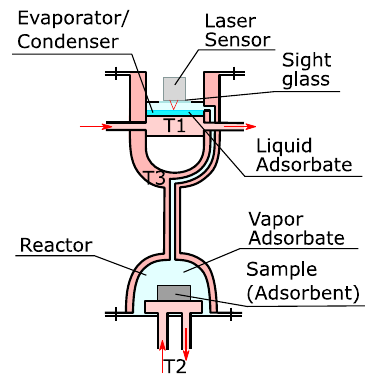
Figure 1. Scheme of the working principle of the new apparatus.